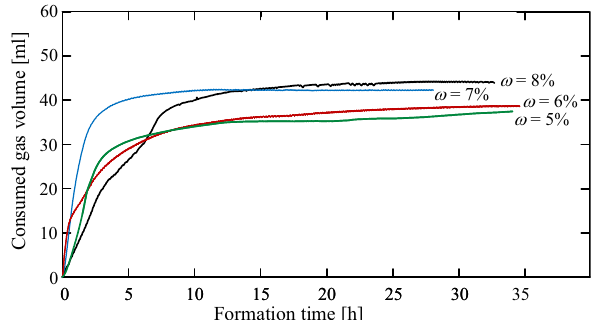
Figure 4. Consumed gas volume by hydrate crystallization during the formation process.